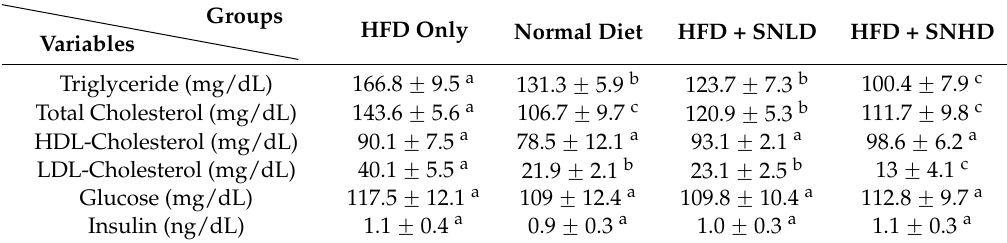
Table 1. Mouse plasma lipid, glucose, and insulin